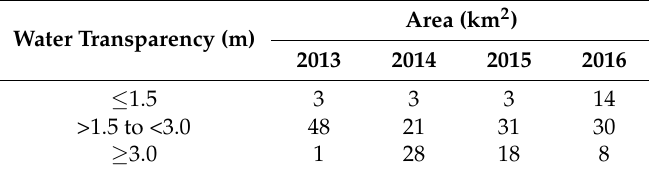
Table 4. Satellite-derived water transparency of the south basin of Lake Biwa (2013–2016).